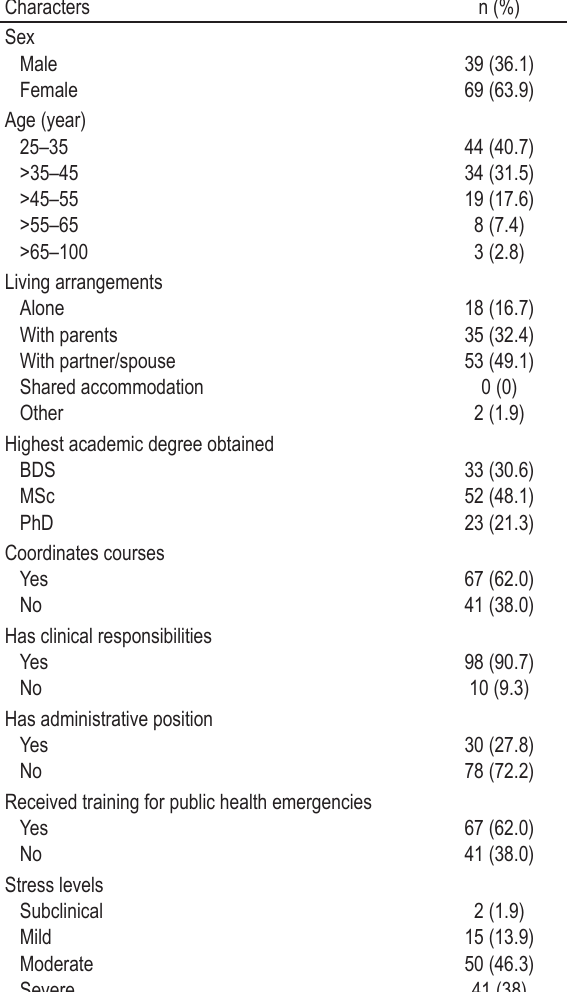
TABLE 1. Personal and professional background of dental academics and their levels of COVID‑19‑related stress (n=108)